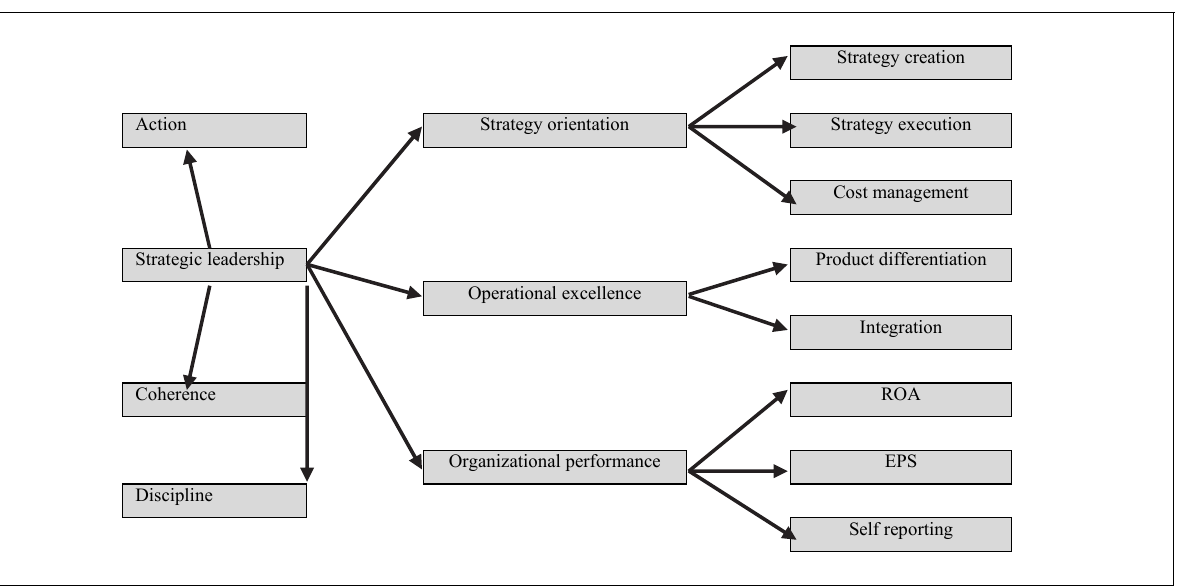
Fig. 1. An illustration of the conceptual correlation model of strategic leadership, strategic orientation, operational excellence and organizational